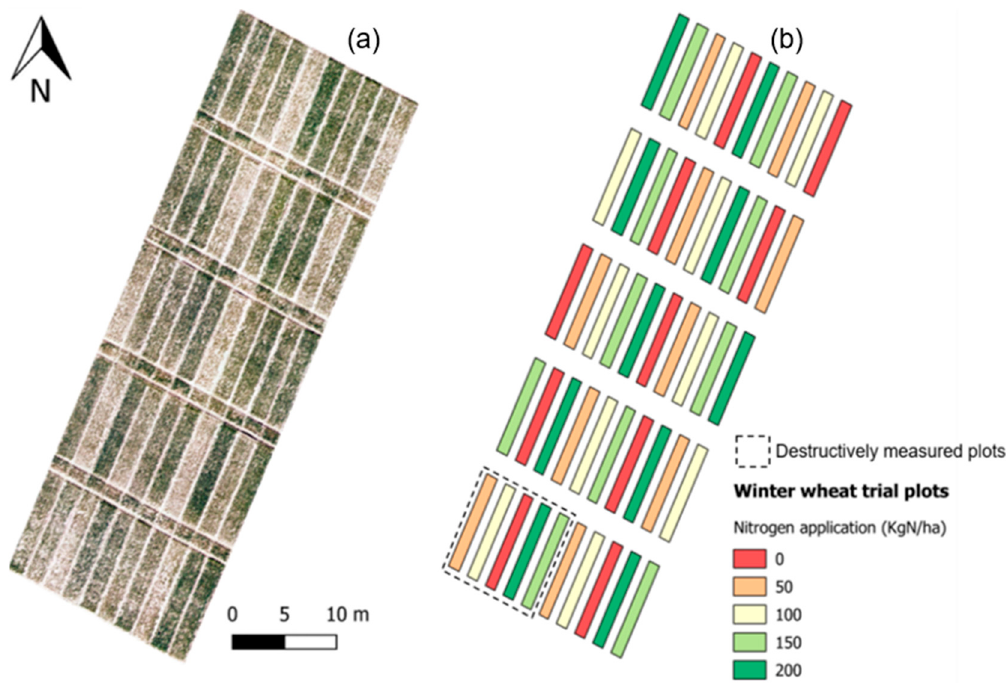
Figure 1. Winter wheat trial plot layout including: ( a ) an aerial image (acquired on 15 May 2018) and ( b ) Latin square experimental design with varying levels of nitrogen application. Destructive sample analysis was carried out at five plots highlighted within the dashed line.